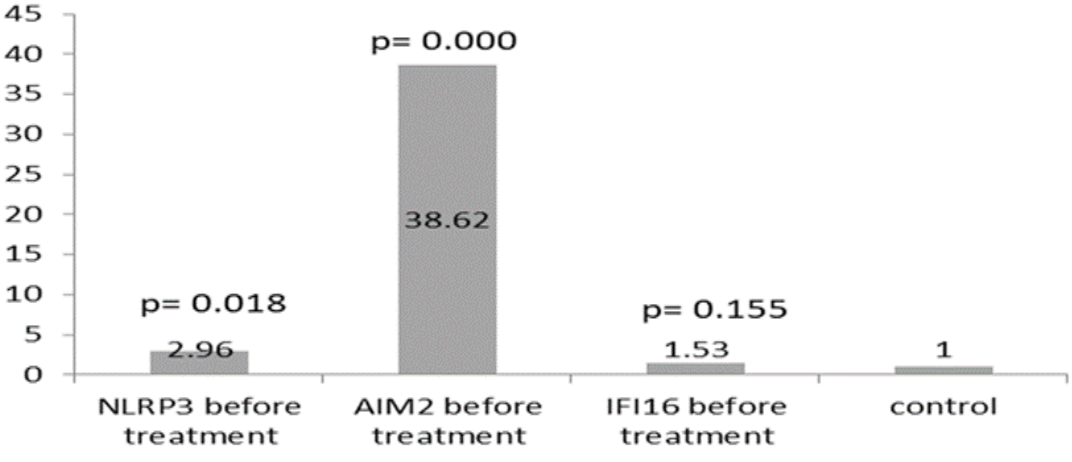
Figure 2. Showing the expression of genes of NLRP3, AIM2, and IFI16 inflammasomes before treatment with DAAs and after SVR12 in chronic HCV patients. Data expressed as median.